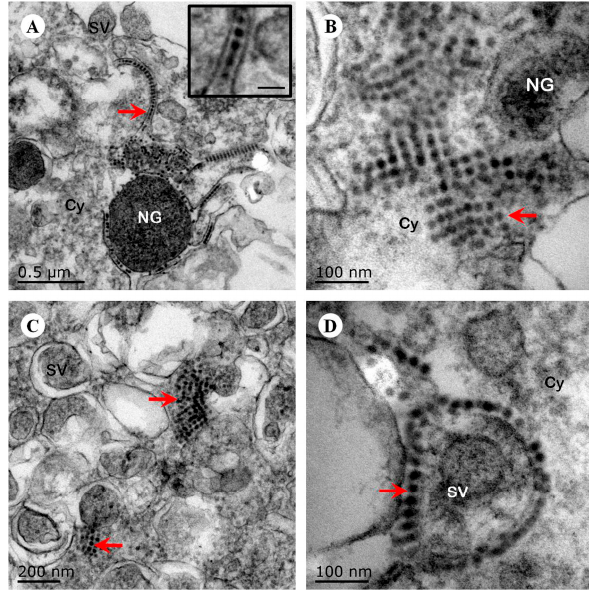
Figure 2. Immunofluorescence assay in human neuroblastoma SK-N-SH cells (magnification 630×). Cells were infected with EV71 Hun12-10, GD10-7, or Hun11-32. Mock-infected and infected cells were fixed at 24 hpi and incubated with mouse anti-EV71 VP2 antibody and rabbit anti- neuron-specific enolase (NSE) antibody, followed by incubation with fluorescein isothiocyanate (FITC)-(green) and tetramethylrhodamine isothiocyanate (TRITC)-(red) conjugated secondary antibodies. The cells were also stained with 4,6-diamidino-2-phenylindole (DAPI) (blue) to visualize the nuclei.